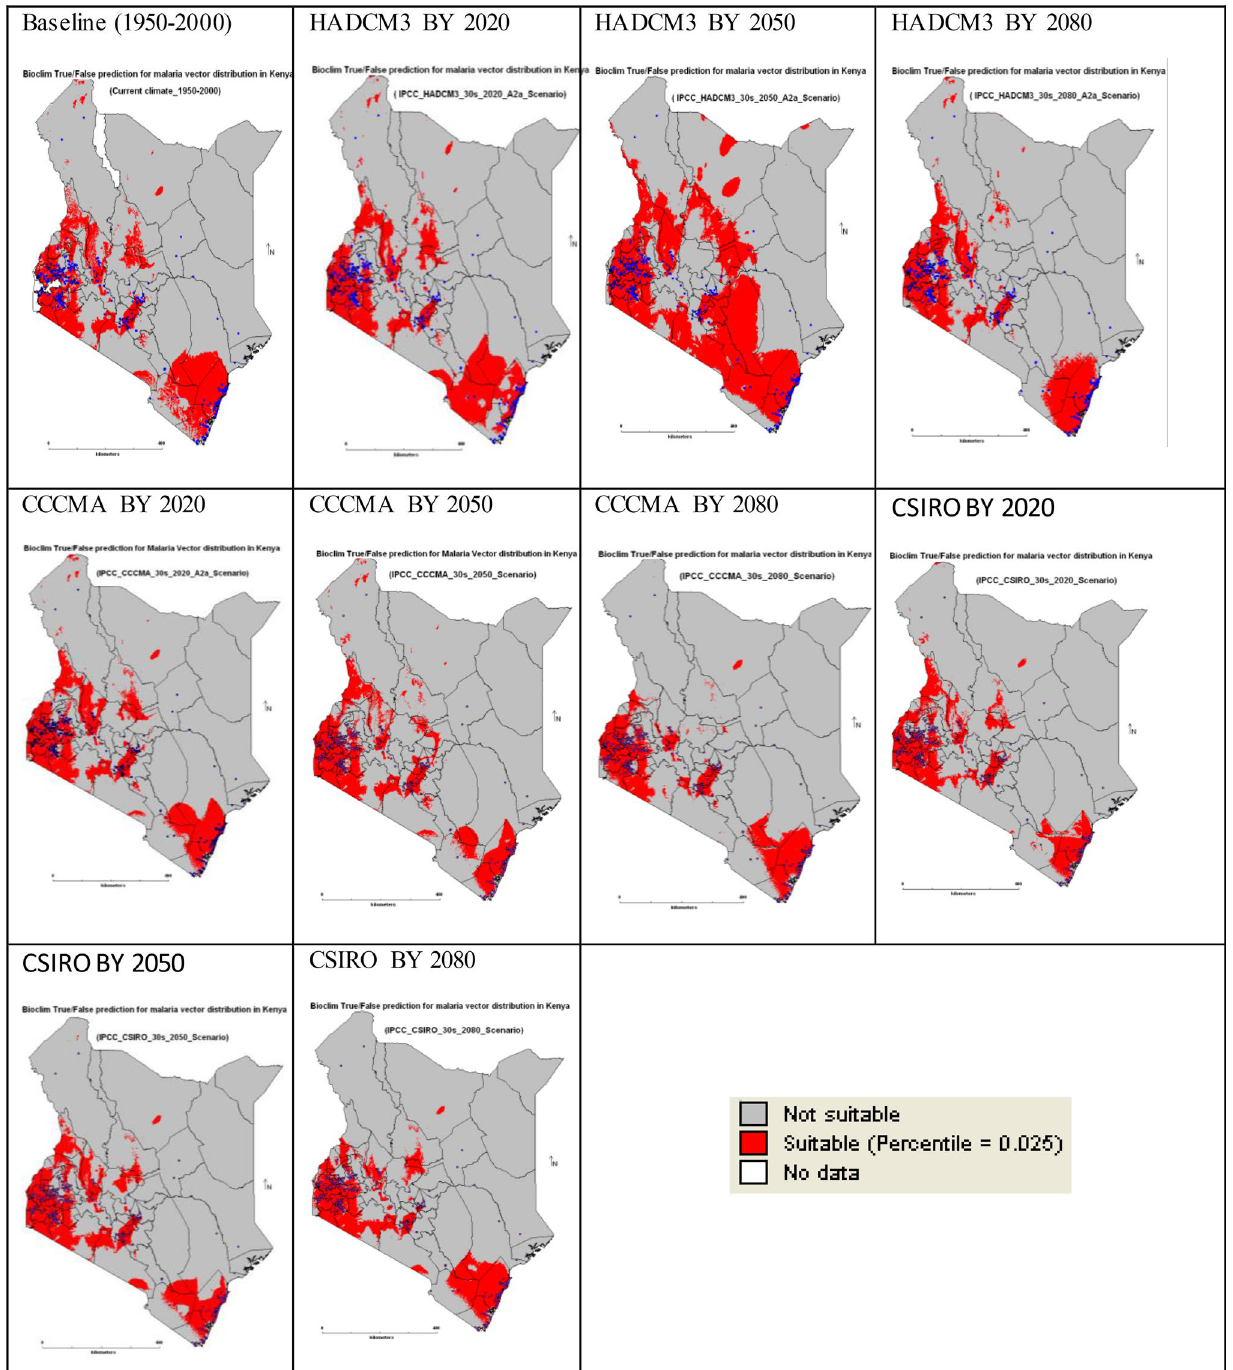
and CSIRO models by 2020, 2050 and 2080. The suitable habitats are shown in red, while gray color denotes the unsuitable